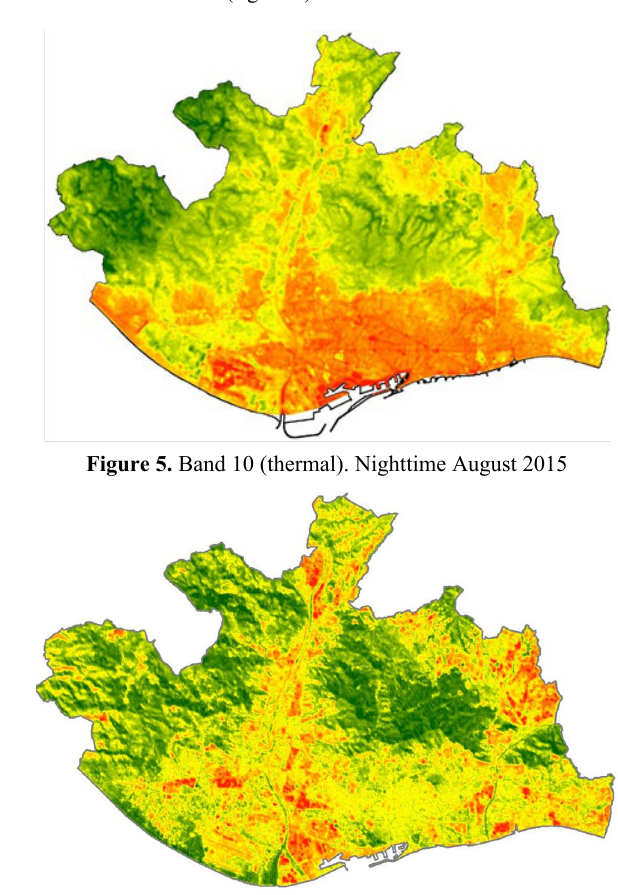
Figure 6. Daytime LST. August